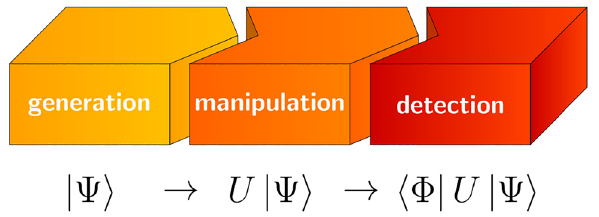
Figure 1: A quantum photonic system is typically built of three blocks. A first block generates a quantum state | | Ψ ⟩ of one or more photons, which is useful for further elaboration. A second block manipulates the state, most often by means of a linear unitary transformation U . The final block performs the detection, which equals to measuring the projection of the elaborated state on one or more quantum states | Φ ⟩